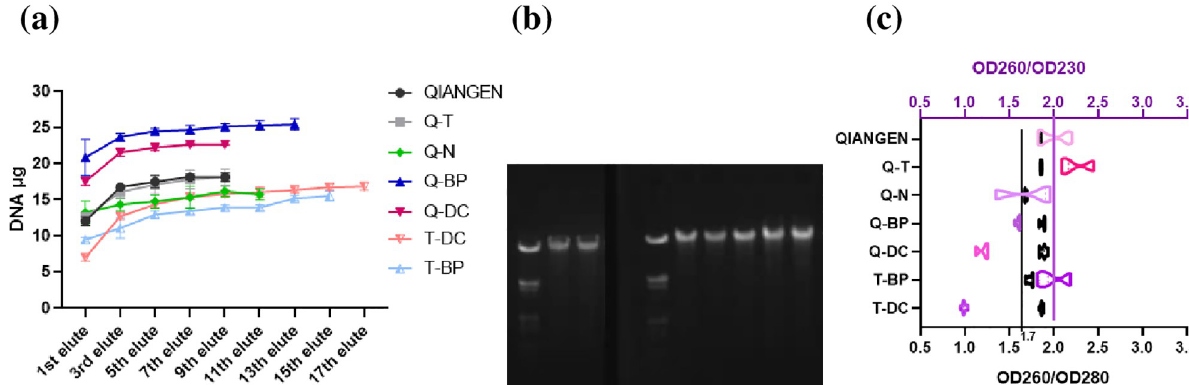
Fig 4. (a) Comparison of DNA extracting capacity of BP, DC and three types of adsorbents from kits using QIAGEN and TIANGEN protocols. (b) DNA electrophoresis of related samples (Marker, � T-DC, T-BP, marker, QIAGEN, Q-NANOEAST, Q-TIANGEN, Q-DC & Q-BP). (c) The OD260/ OD280 (black) and OD260/OD230 (purple) purity ratios of related samples. � T-, Q-, -T and -N refer to TIANGEN protocol, QIAGEN protocol, TIANGEN adsorbent and NANOEAST beads,